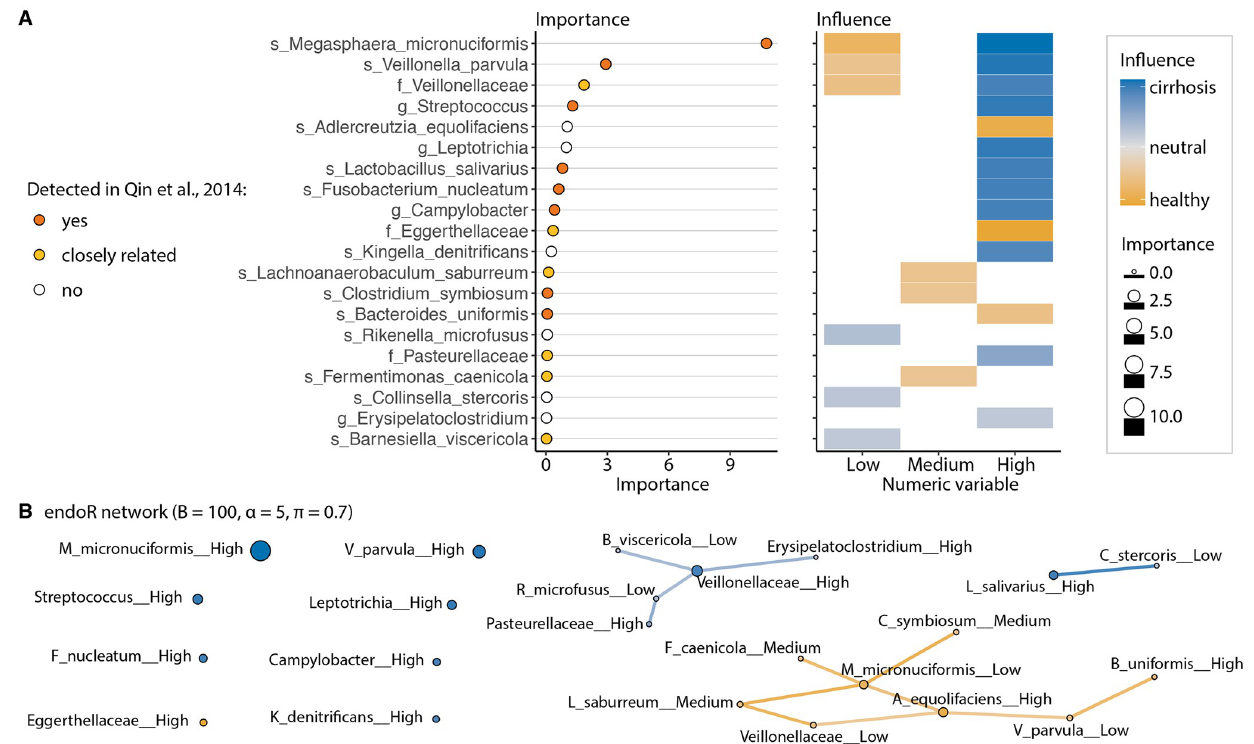
Fig 5. endoR recapitulates previous findings on differences in gut microbiomes between healthy individuals and patients diagnosed with cirrhosis. A: Feature importance aggregated across each level of discretized variables and influence per-level as determined by endoR. Levels correspond to discrete variable categories, and here represent relative abundance groups created by endoR (i.e., whether samples had ‘Low’, ‘Medium’ or ‘High’ relative abundances of each taxon). ‘closely related’ designates taxa that are the direct parent or child taxonomic classification of a taxon originally associated with disease status in Qin et al. [41]. White boxes in the influence plot signify that the level was not used in any stable decision; thus, the influence could not be calculated. B: Decision network extracted from the stable decision ensembles. See Fig 2 for the description of the network; the boxed legend is shared for A and